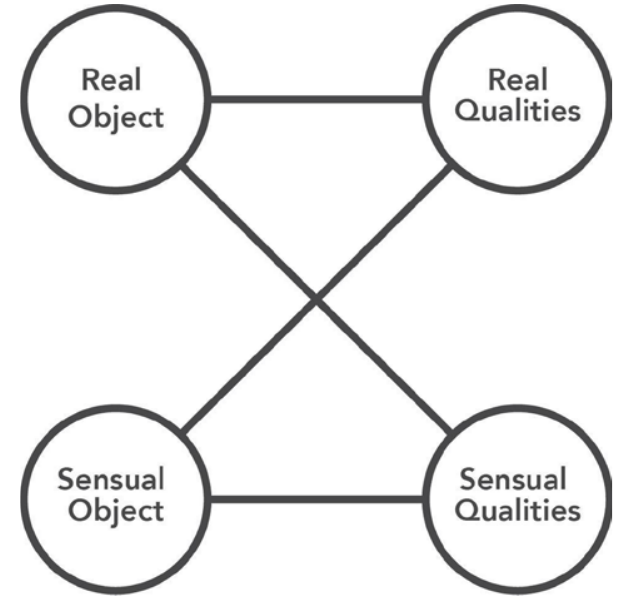
FIG. 4 The quadruple object diagram by Graham Harman,